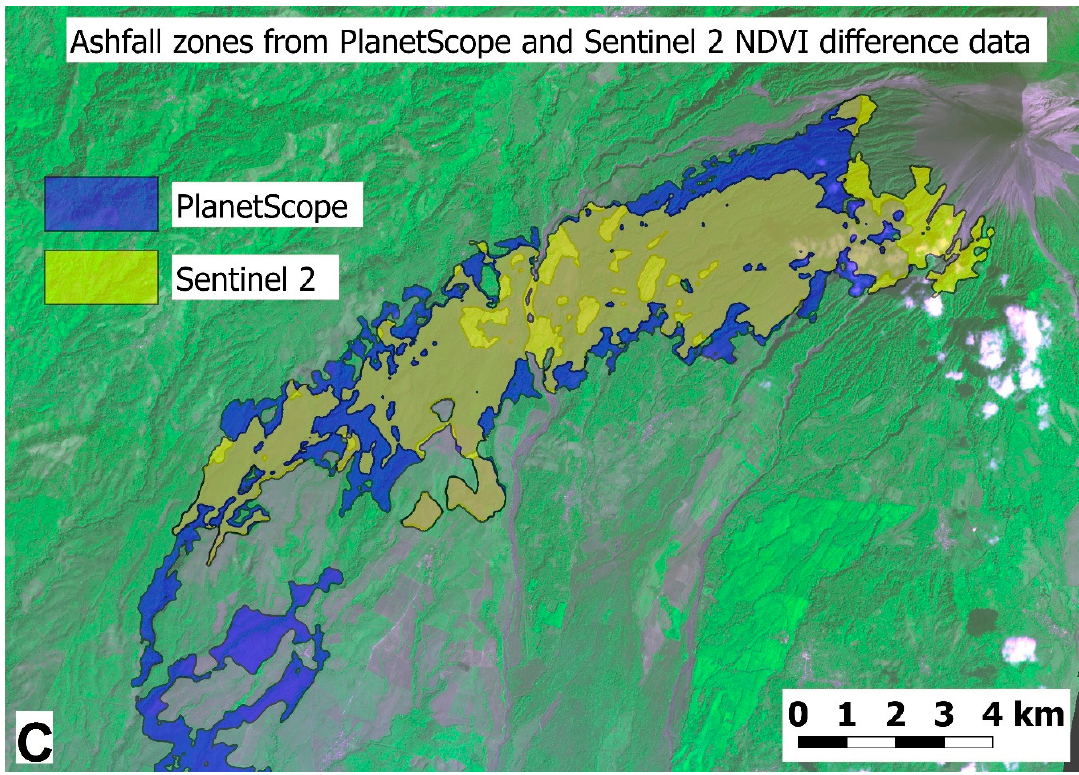
Figure 4. Tephra fall deposit mapped using NDVI difference analysis of ( A ) PlanetScope and ( B ) Sentinel 2 images from 9 th 10 th January and 4 th February 2018. Threshold values of –0.1 for Sentinel 2, and–0.125 for PlanetScope were used to identify the ash covered areas shown in red in ( A ) and ( B ). ( C ) Shows the areas that can be identified as ash covered by the NDVI differences in each set of satellite images after applying a low-pass filter and converting them to polygons (only taking the connecting polygons along the expected dispersal axis). BOA = Bottom of Atmosphere. Background image is a PlanetScope image from February 4, 2018 at 15:58 UTC.